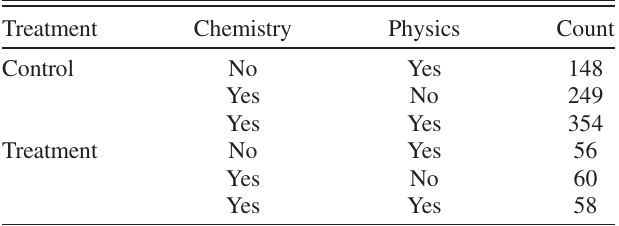
TABLE II. Data patterns for chemistry and physics by PPG